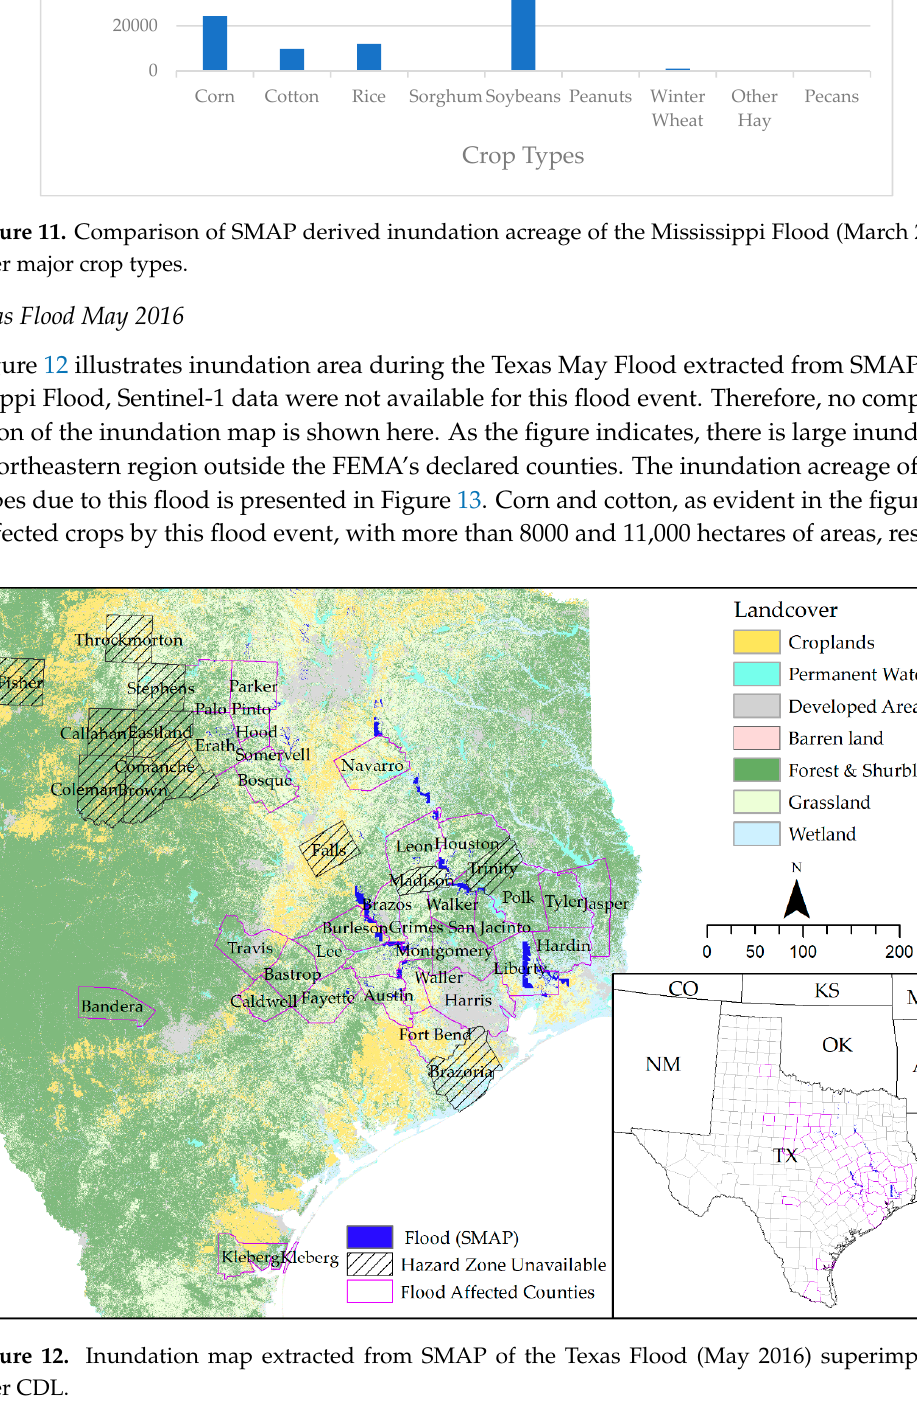
Figure 10. Inundation map extracted from SMAP of the Mississippi Flood (March 2016) superimposed over CDL.